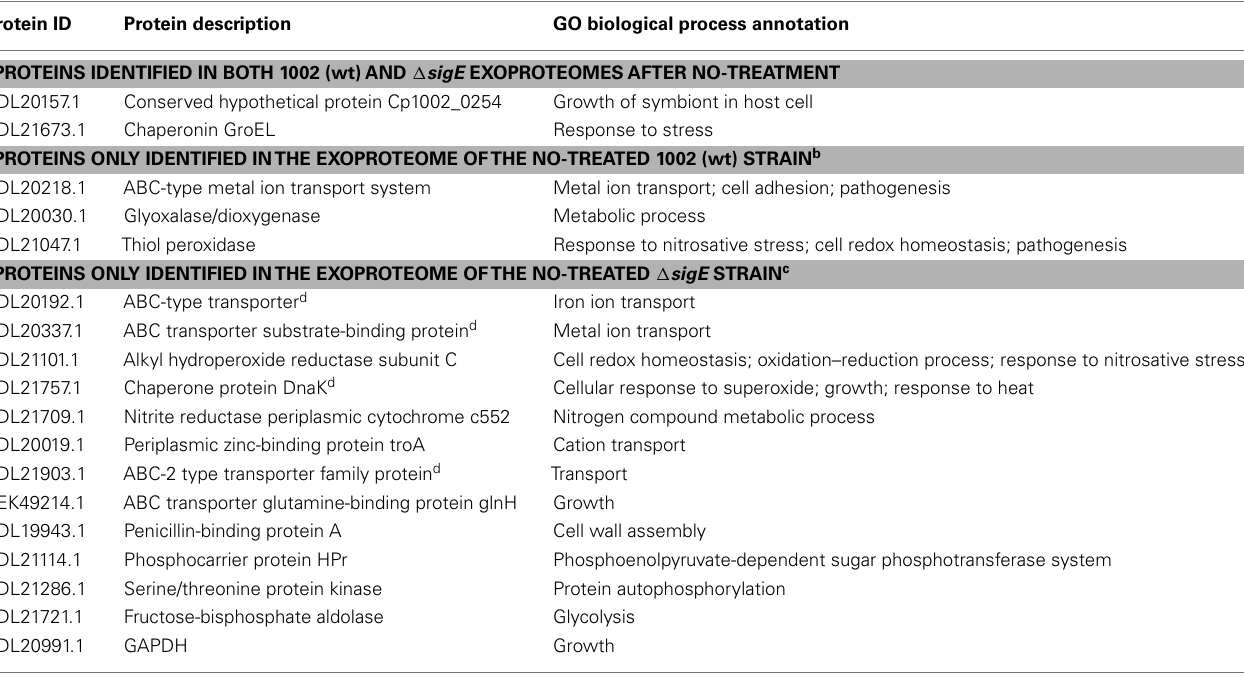
Table 1 | Proteins identified in the exoproteomes of the 1002 (wt) and Δ sigE strains of C. pseudotuberculosis following NO-stress a . Protein ID Protein description GO biological process